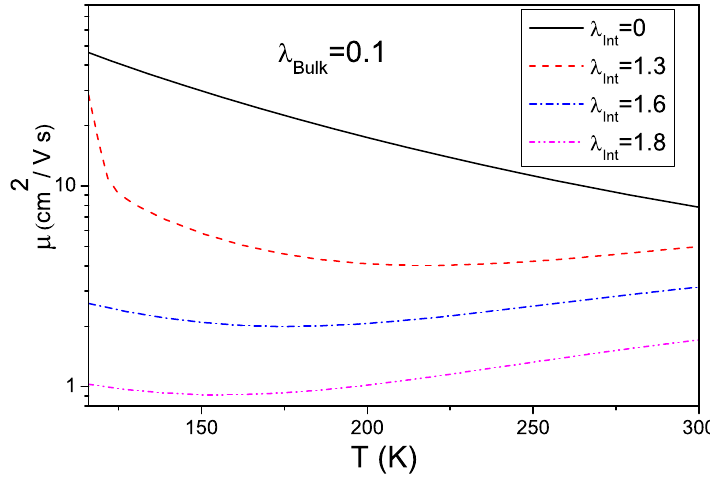
Figure 9. Mobility µ as a function of the temperature, T, at λ of λ Int